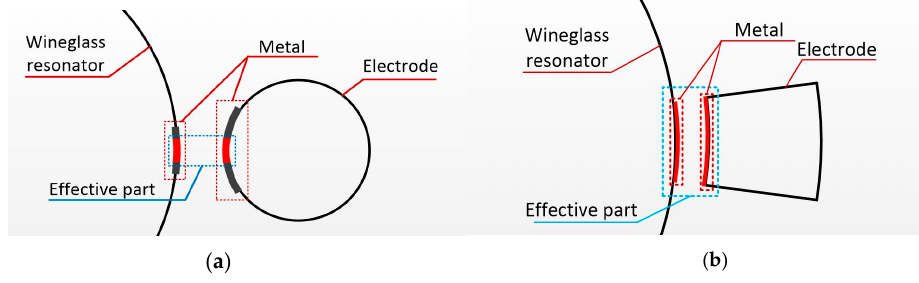
Figure 1. ( a ) The shape of electrode in [6]; ( b ) The shape of electrode in this paper.